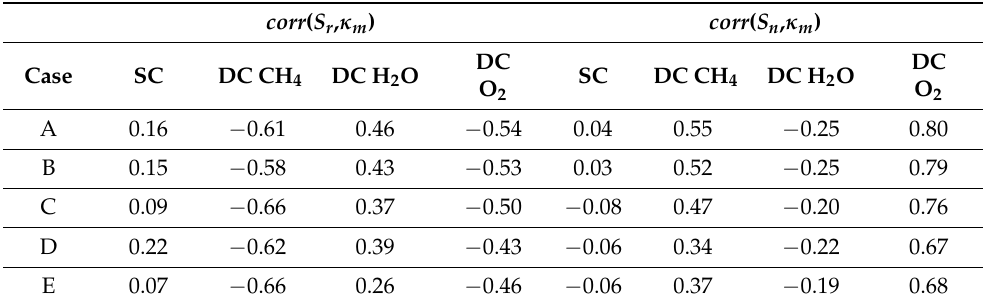
Table 11. Correlation coefficients between S r and S n with κ m for the c = 0.8 isosurface value for all cases.